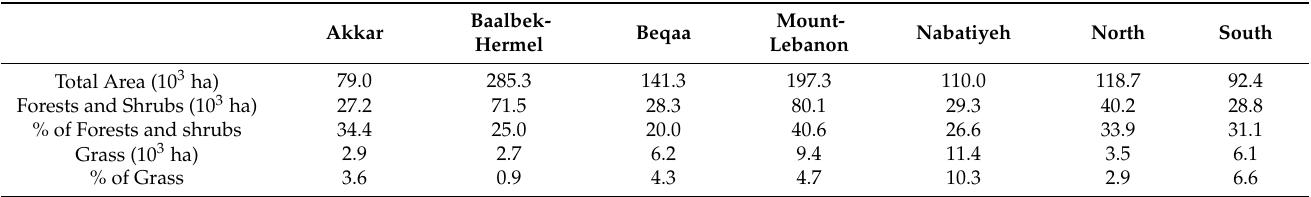
Table 1. Forests/shrubland and grassland cover (10 3 ha) in Lebanon per governorate (adapted from [48]) and their respective percentage